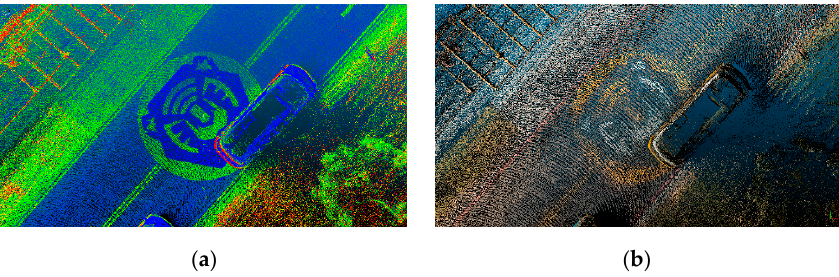
Figure 22. Top views showing the icon of the test area of the ( a ) intensity point cloud; ( b ) color point cloud constructed by the proposed method.